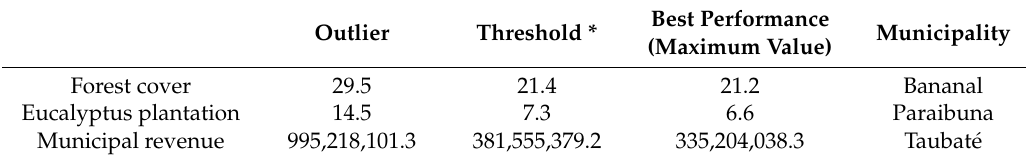
Table 2. Selected municipalities to develop the rural household survey.